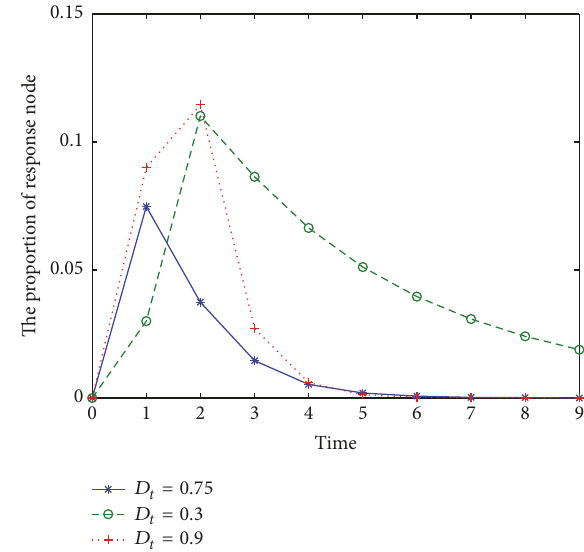
Figure 7: The proportion of responsive sensors.